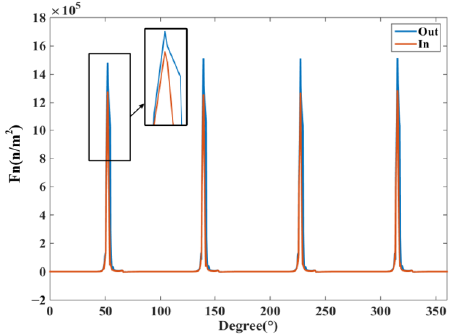
Figure 12. ERF waveform with rotor position.